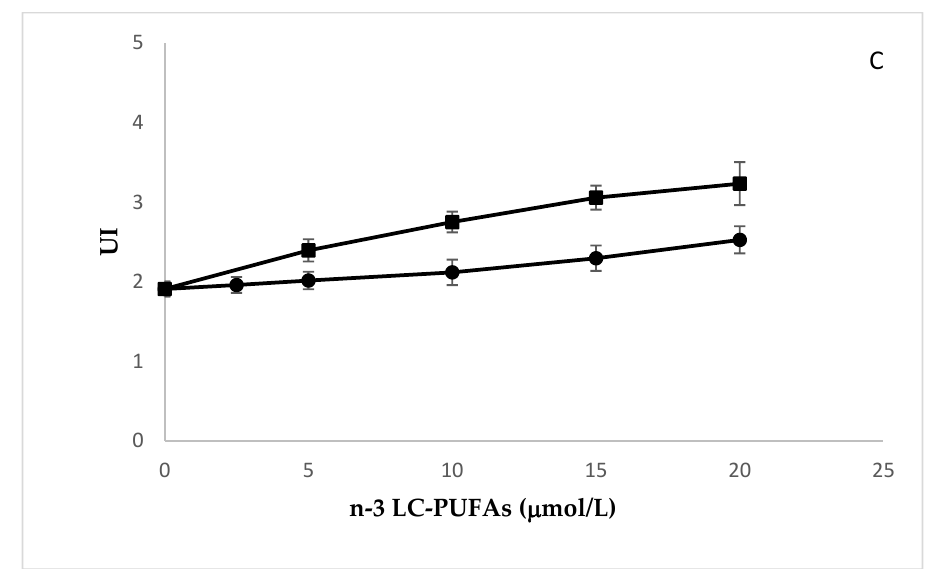
Figure 2. Incorporation of EPA or DHA in HMEC. ( A ): Basal levels of EPA and DHA. * EPA vs DHA p ≤ 0.001 ( B ): incorporation of EPA (●) and DHA ( ∎ ) after 24 h of cell incubation with increasing amounts of these n-3-LC-PUFAs. ( C ): Changes of unsaturation index (UI) after cell incubation with increasing amounts of EPA (●) and DHA ( ∎ ). Pearson’s r = 0.9999, p < 0.0001 and Pearson’s r = 0.9996, p < 0.0001. Slope EPA vs. slope DHA p ≤ 0.0001.